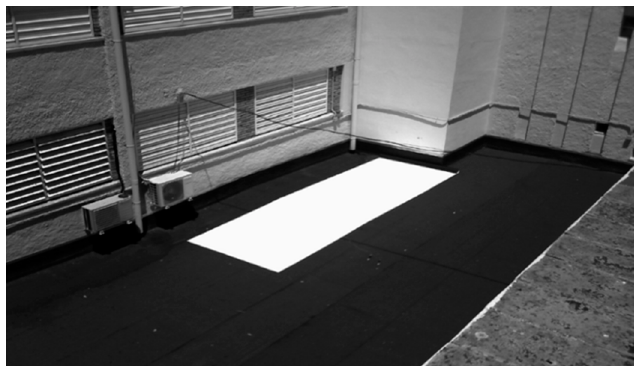
Figure 10. Case study 1: Waterproof polymer roofing SIKA ® membrane placement.